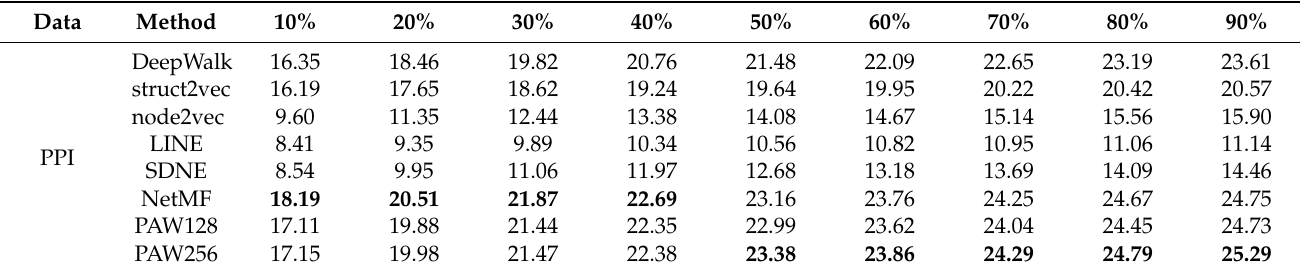
Figure 5. Weighted-F1 of multi-label classification on the BlogCatalog dataset on varying the propor- tion of training data. Table 2. Results of multi-label classification on the PPI dataset with the ratio of training data from 10% to 90% on the Micro-F1 evaluation